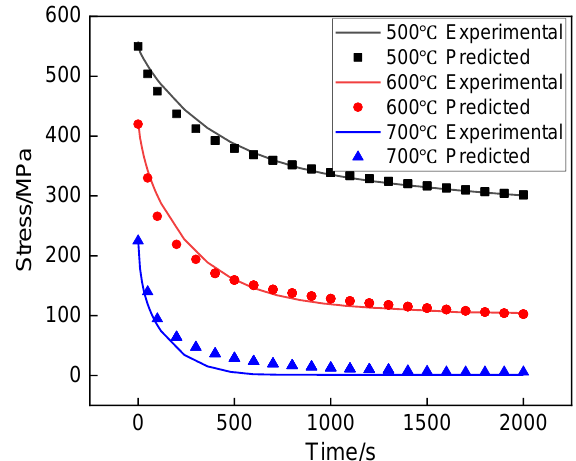
Figure 9. Comparisons between experimental and predicted results.